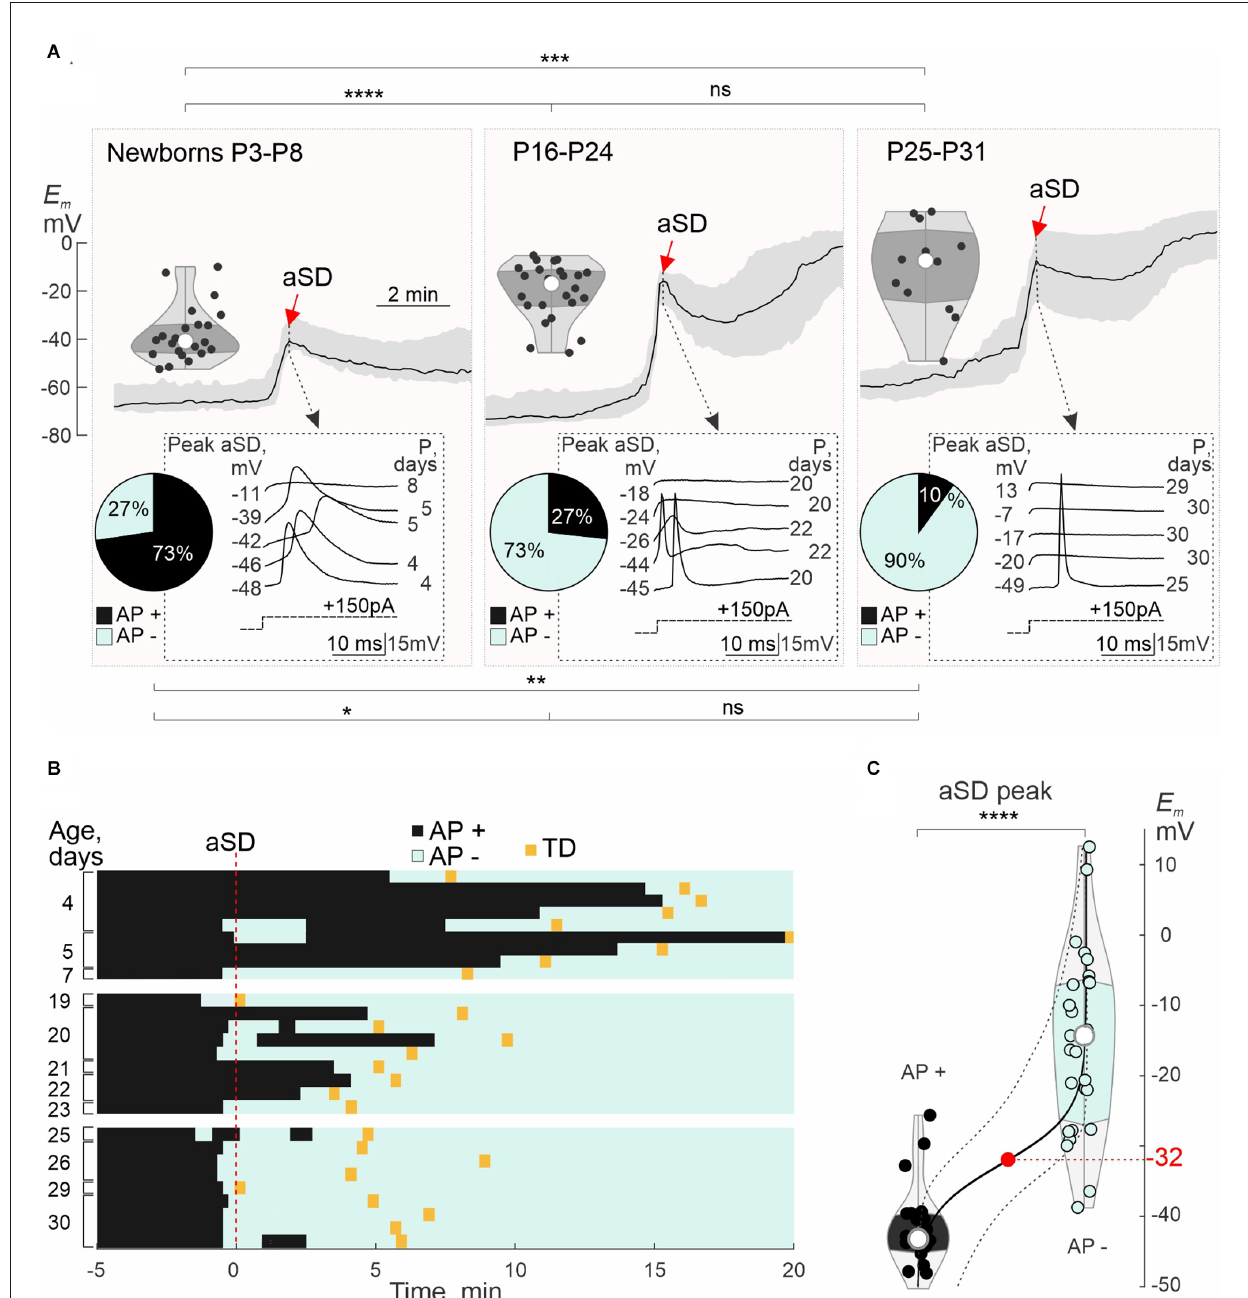
FIGURE4 Postnatal changes in aSD peak value and neuronal firing during aSD: group data. (A) Top traces, grand average aSD (black trace—median Em ; shaded area—interquartile range) and corresponding statistical plots of E m values at the aSD peak in L4 neurons from newborn (P3–P8, n = 22 cells), and juvenile rats (P16–P24, n = 24 cells; and P25–P31, n = 12 cells). Gray insets below, examples of responses to depolarizing current steps at the aSD peak in five neurons from each age group, with the corresponding E m aSD peak value (left) and age (right). Circular histograms show neuronal firing at the aSD peak (black—AP+ neurons responding with APs to depolarizing steps, cyan—AP − neurons not showing APs in response to depolarizing steps). Note that in newborn animals, neuronal depolarization reaches only a weak level during aSD, that most newborn neurons retain neuronal firing during aSD, and that ability to fire APs during aSD diminishes with age. (B) Representative raster plots of APs evoked by depolarizing current steps (inter-step interval 10 s) in L4 neurons of different age groups during OGD-induced aSD ( T = 0, vertical red dashed line). The black and